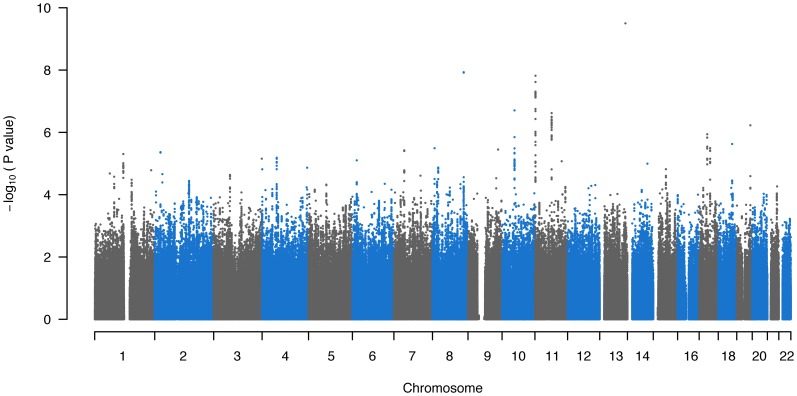
Manhattan Plot of Results for Imputed HapMap Phase II and Phase III SNPs.